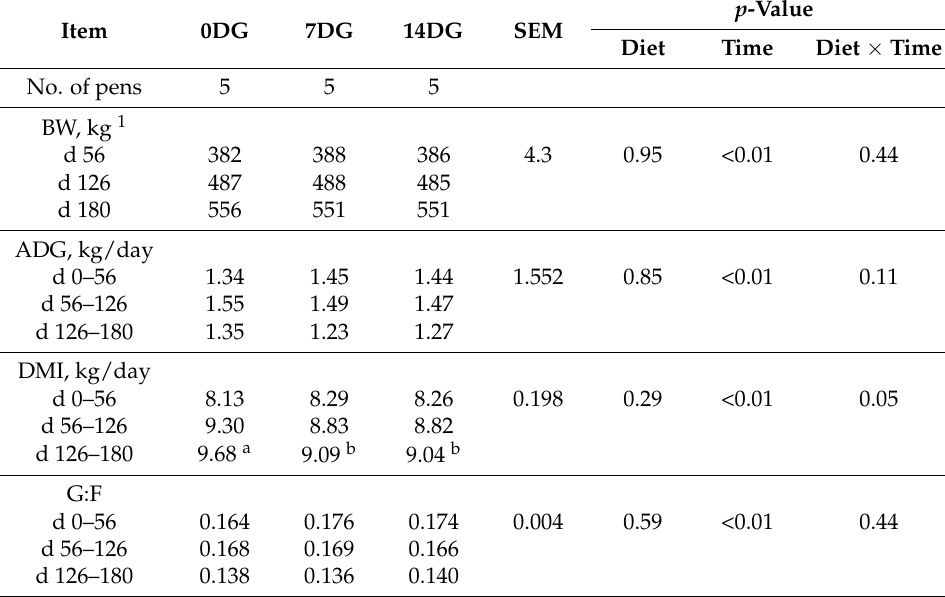
Table 2. Effect of distillers grains inclusion level on body weight (BW), average daily gain (ADG), dry matter intake (DMI), and gain to feed ratio